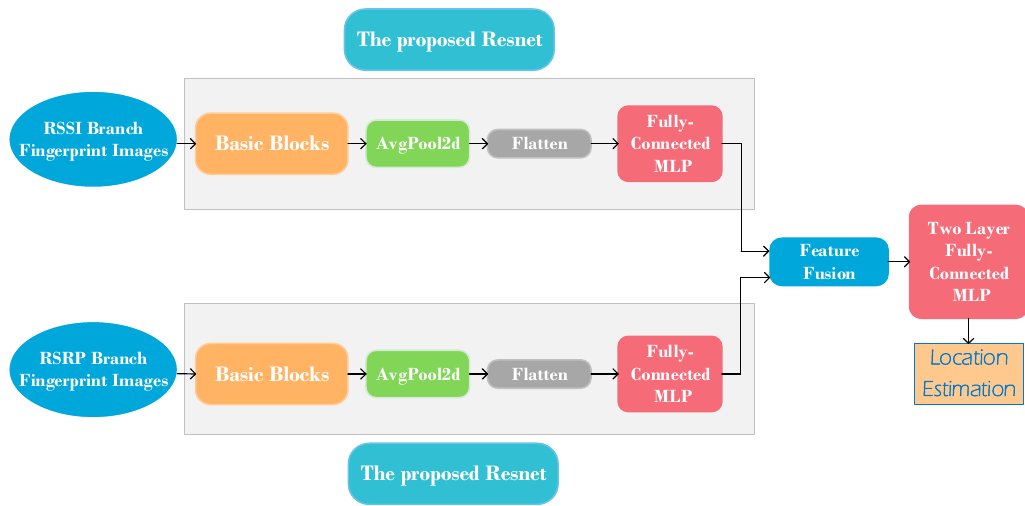
Figure 8. Architecture of proposed united branch positioning method.